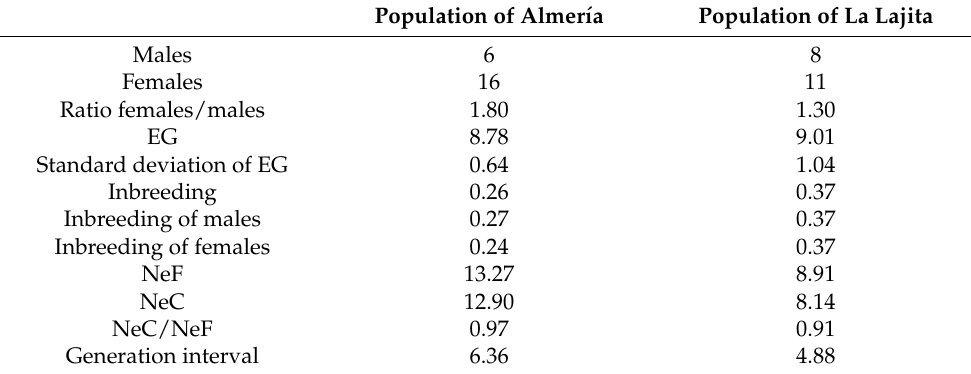
Table 1. Structure data of the reference populations of Almer í a and La Lajita (EG, equivalent complete generation; NeF, effective population size based on individual increase of inbreeding; NeC, effective population size based on increase of